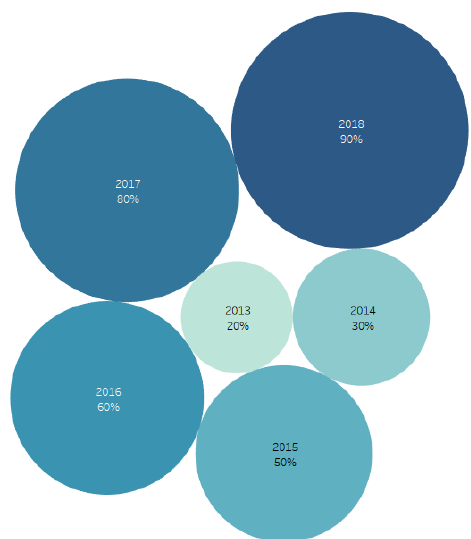
Figure 1. Percentage increase in image